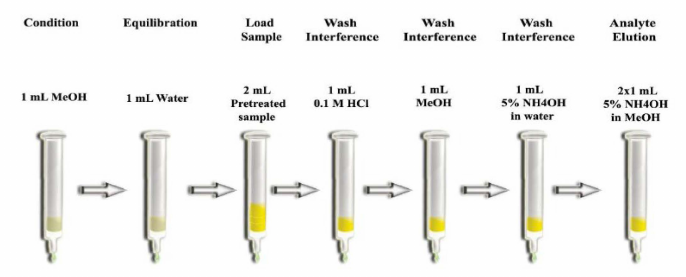
Figure 2. Schematic diagram of mixed-mode solid-phase extraction (MMSPE).